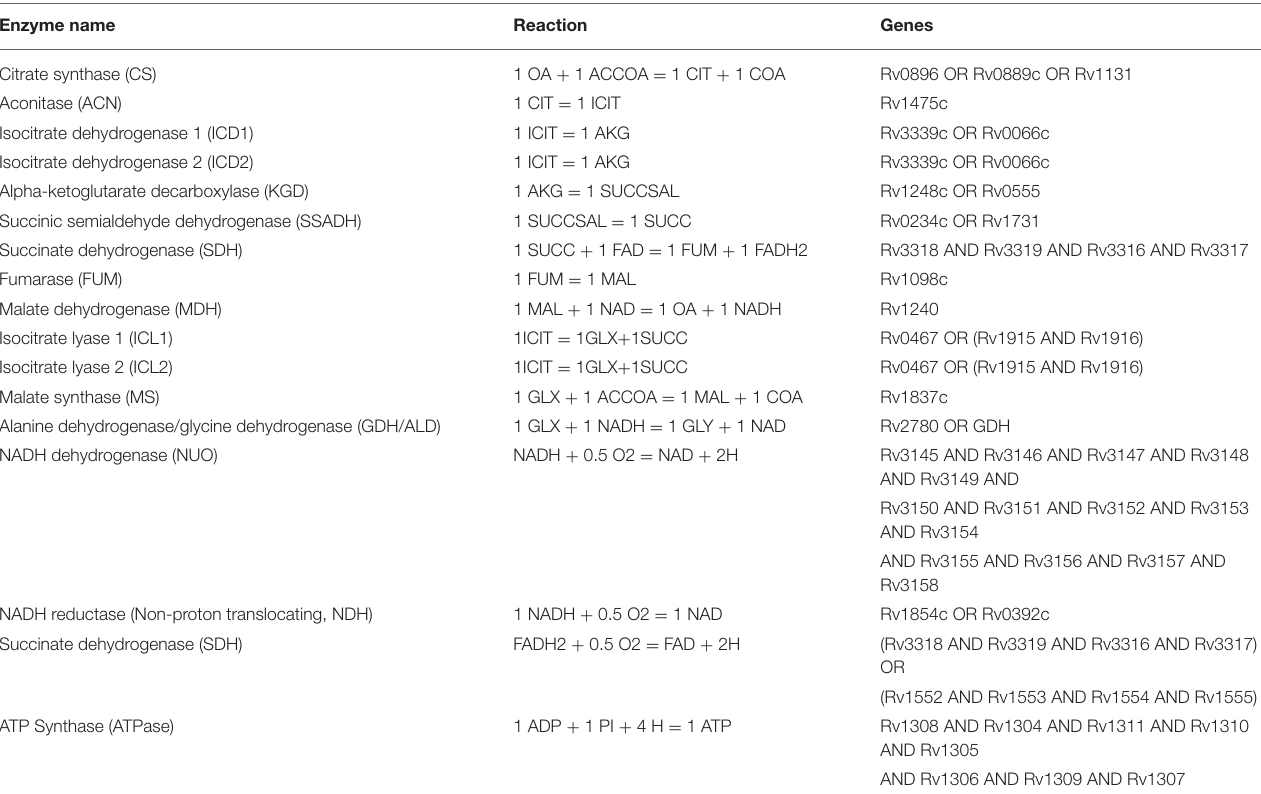
TABLE 4 | Reactions included in the Mtb systems biology model to capture the TCA cycle, glyoxylate to glycine shunt, electron transport chain, and oxidative